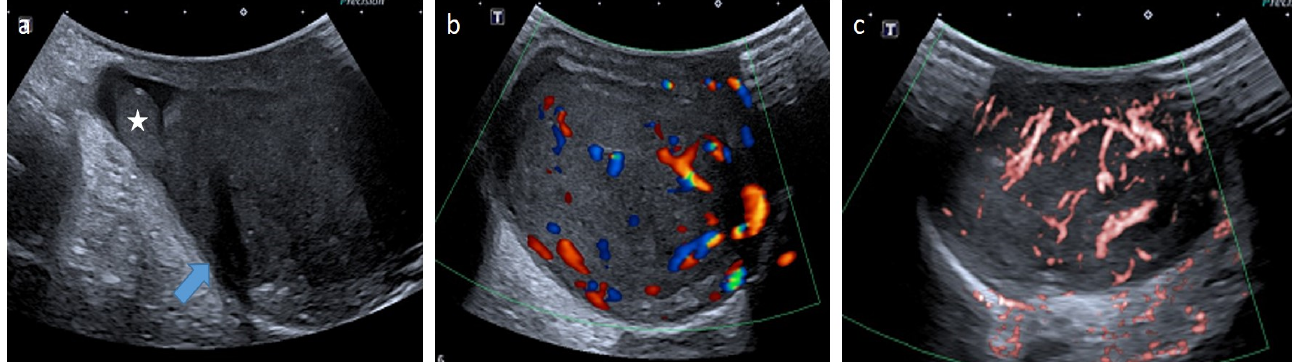
Figure 13. Para-testicular rhabdomyosarcoma in an 8-year-old boy (case 1). Transverse gray-scale B-mode ( a ), color Doppler ( b ) and power Doppler ( c ) US of the scrotum. Images show a solid lesion (blue arrow) in an extra-testicular location (testis is represented by a star), with heterogeneous aspect and showing high and irregular vascularization. Inguinal radical orchidectomy was performed, followed by a course of chemotherapy. The margins were safe. US, ultrasonography.